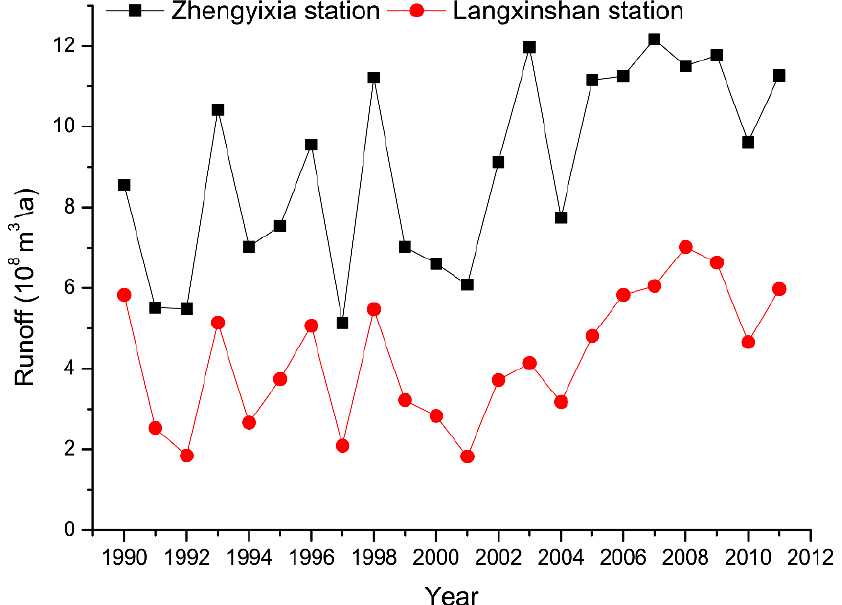
Figure 9. Runoff from the Zhengyixia and Langxinshan hydrological stations between 1990 and